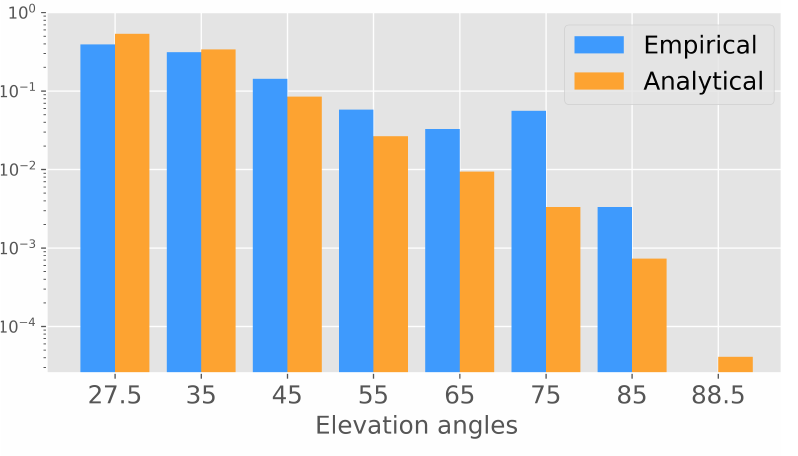
Figure 4. Probability that a satellite is visible from UE at given satellite elevation angles in